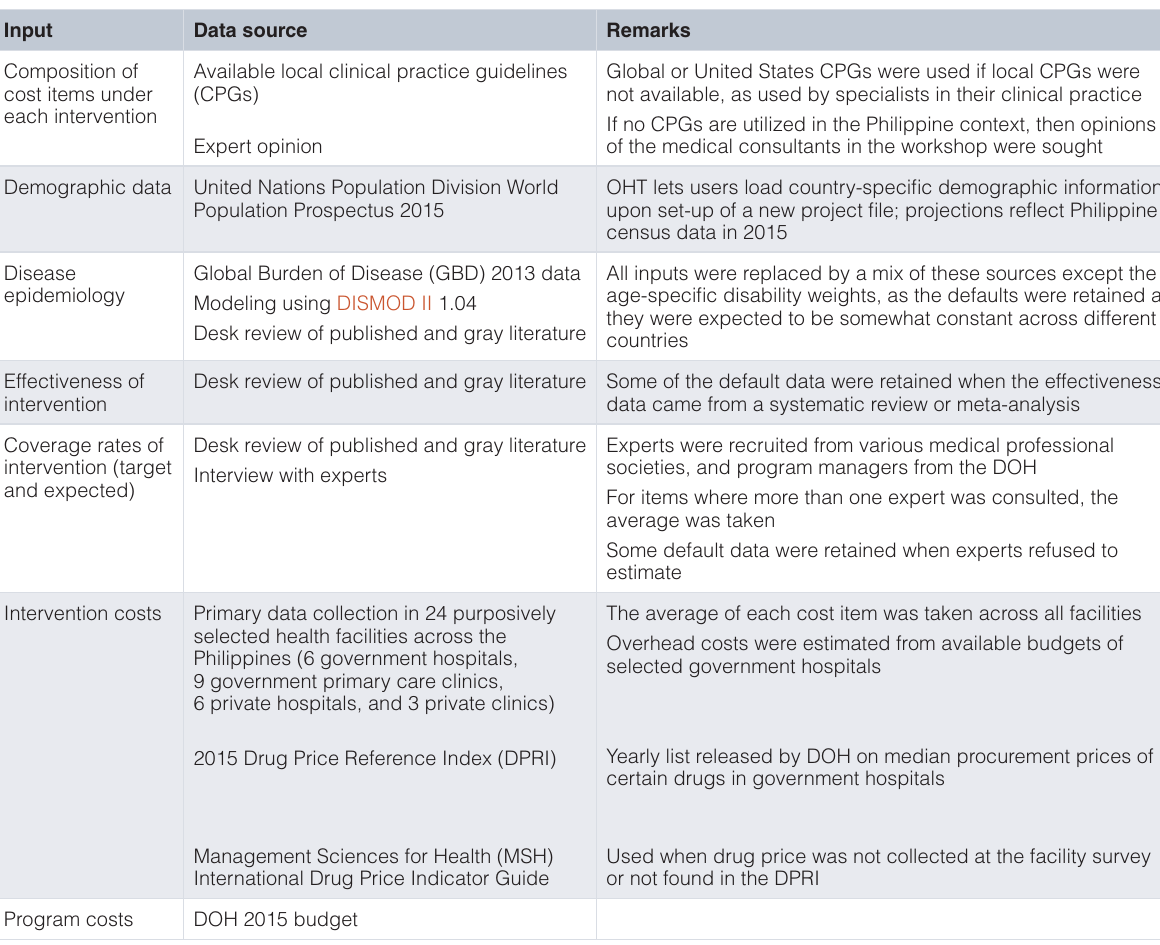
Table 1. Data sources used for inputs in the OneHealth